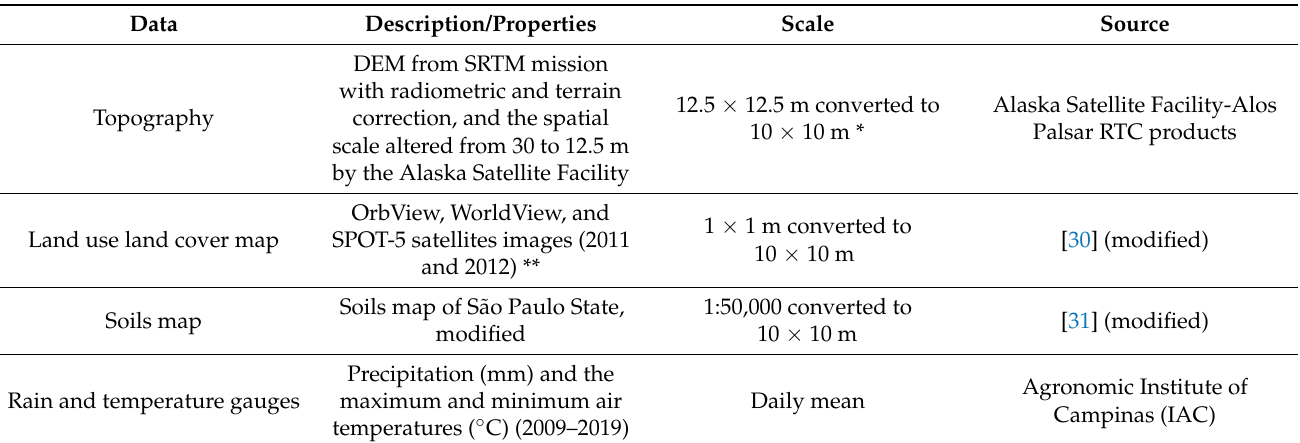
Table 1. Input data and sources used for the model